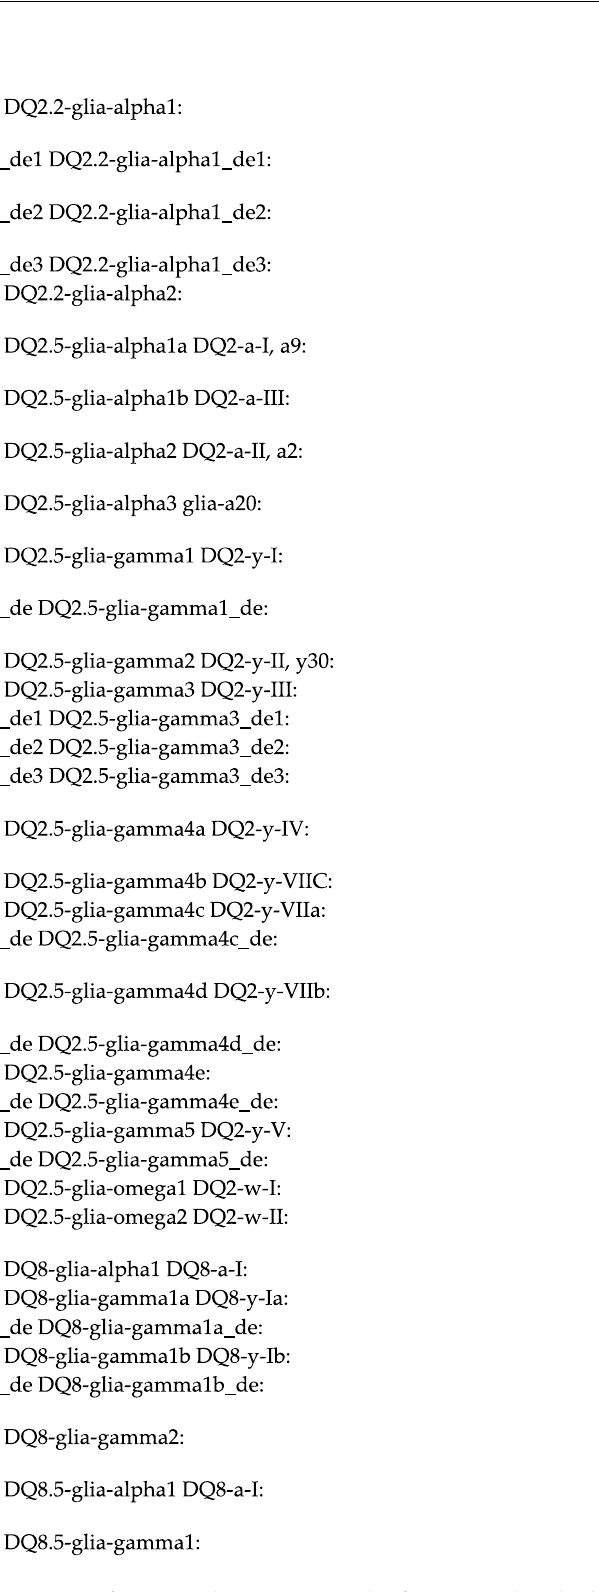
Figure 6. List of immunodominant peptides from α‐ and γ‐ gliadins determined by Sollid et al. [13], showing the putative pepsin (red exclamation point) and trypsin (blue exclamation point) cleavage sites predicted by PeptideCutter. Excised parts from the peptides are in red-boxed white letters. Peptides uncleaved by pepsin or trypsin are highlighted in green.